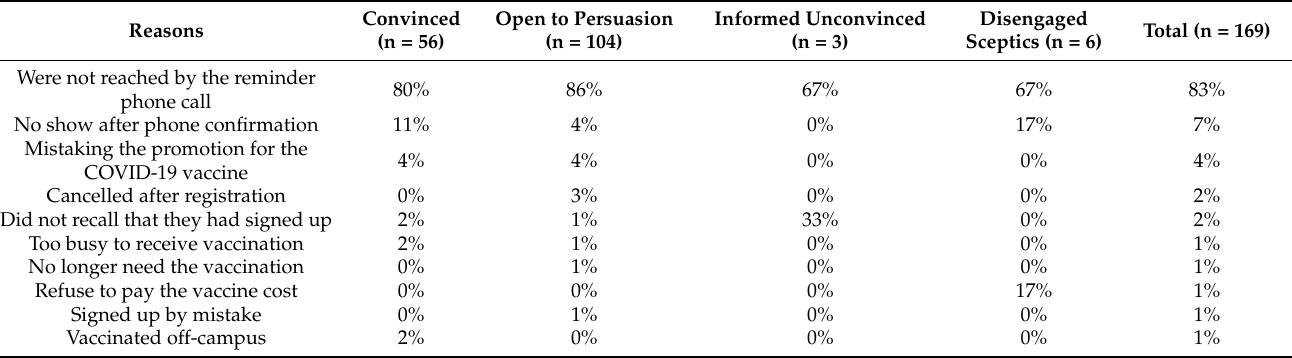
Table 1. Reasons why registrants did not get vaccinated.